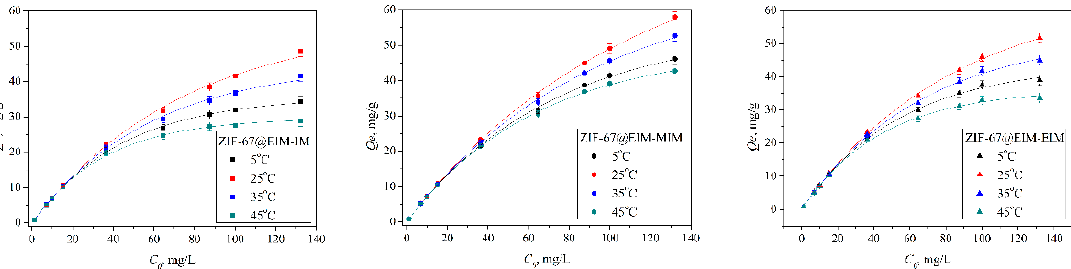
Figure 3. The relationships between initial concentration ( C 0 ) and adsorption amount ( Q e ) of AAI on three sorbents at 5, 25, 35 and 45 °C.